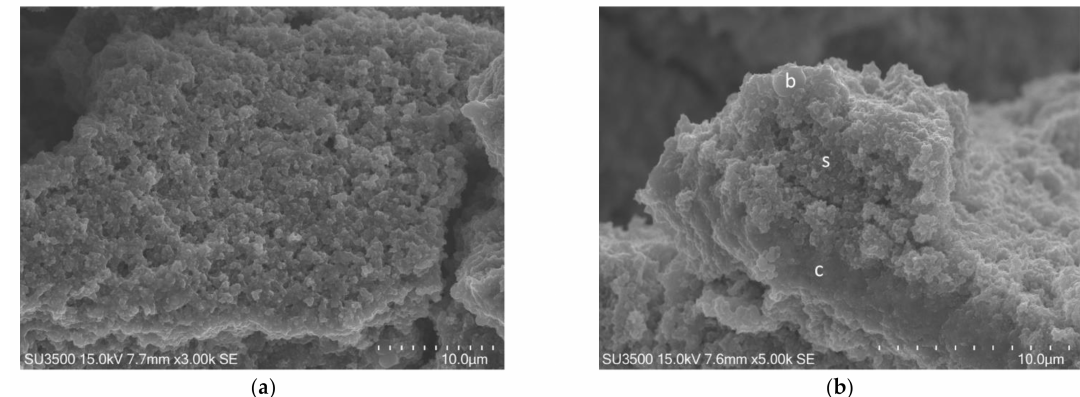
Figure 5. S. mutans prepared by the OsO 4 -RR-TA-IL procedure. ( a ) 3000 × . The biofilm topography showed a spongy appearance. ( b ) 5000 × . The biofilm topography showed both compact, c, and spongy, s, appearance, a single bacterial cell, b, was partially embedded in Eps.